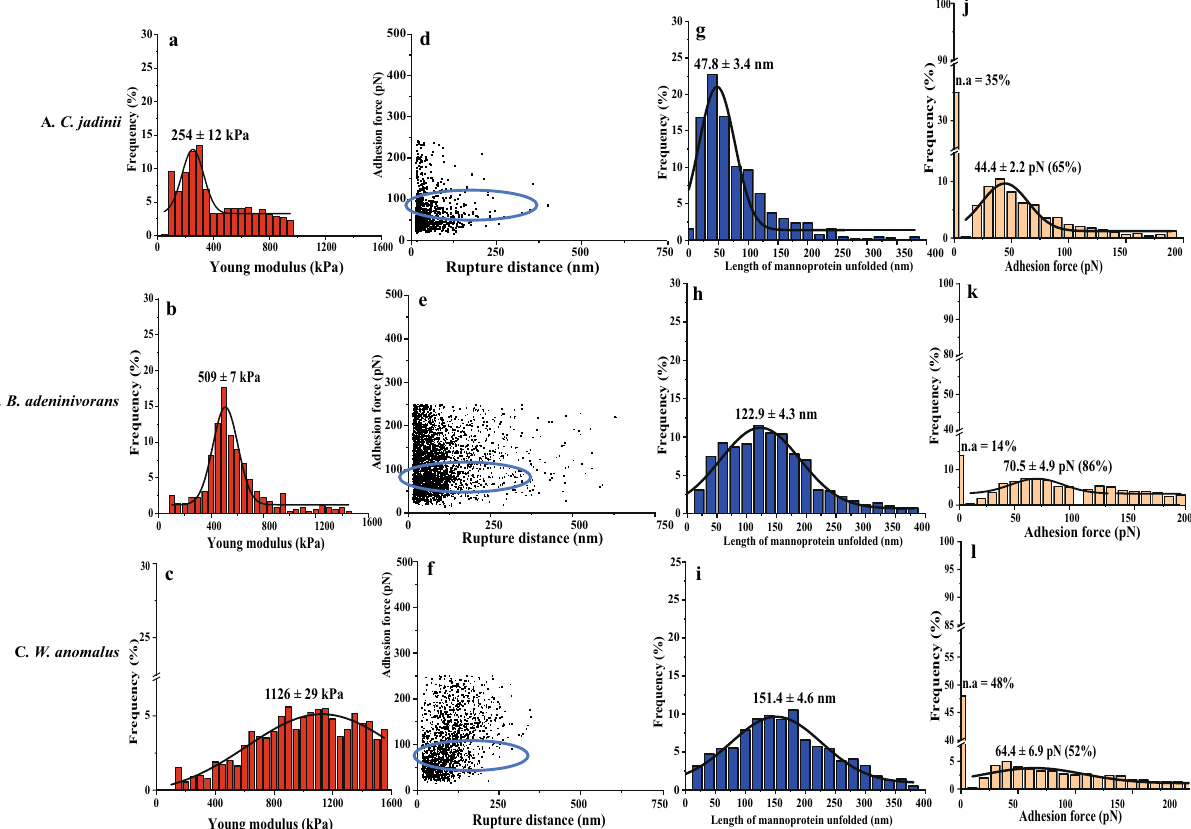
Figure 5. Probing cell wall architecture of three inactivated yeast species ( A – C ) with Atomic Force Microscopy, using naked tips ( a – c ) or tips functionalized with (mannan-binding) concanavalin A ( d – l ). The graphs show the distribution of the Young modulus ( a – c ), the relationship between adhesion force and rupture distance ( d – f ), the distribution of the length of mannoprotein unfolded ( g – i ), and the frequency of adhesion events with varying adhesion forces ( j–l ). In panels j–l, n.a . stands for non-adhesion. Rows A , B and C show results for Cyberlindnera jadinii , Blastobotrys adeninivorans and Wickerhamomyces anomalus , respectively. The data were obtained from 3 cells (3072 curves were analyzed with JPK data processing software before fitting Gaussian curves on the distribution). The blue circle highlights the rupture distance at the adhesion force for